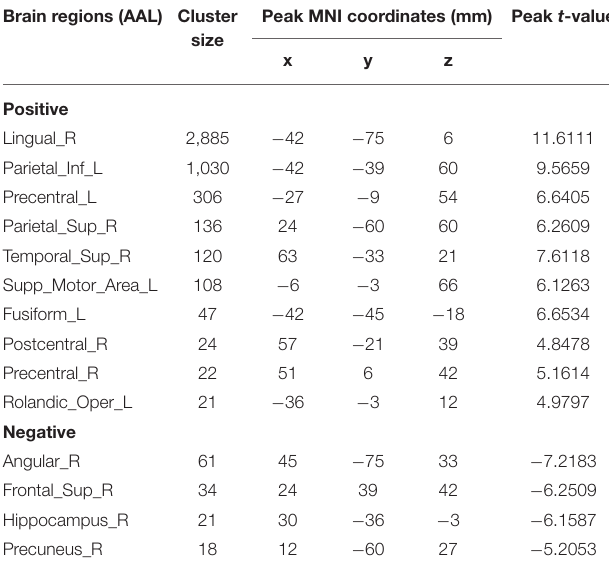
Brain regions (AAL) Cluster